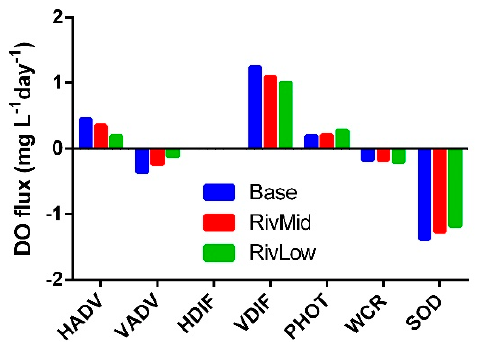
Figure 9. DO budget of the river run in the bottom layer of the Modaomen hypoxic zone during June–August. The acronyms related to the DO budget and their descriptions are supplemented in Table A1 in the Appendix .